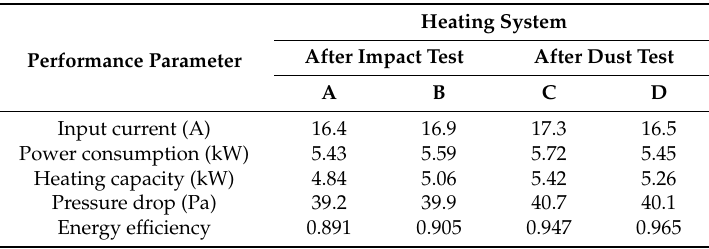
Figure 11. External appearance of a prototype of the heating system before and after a dust test. Table 10. Results of heating performance experiments.